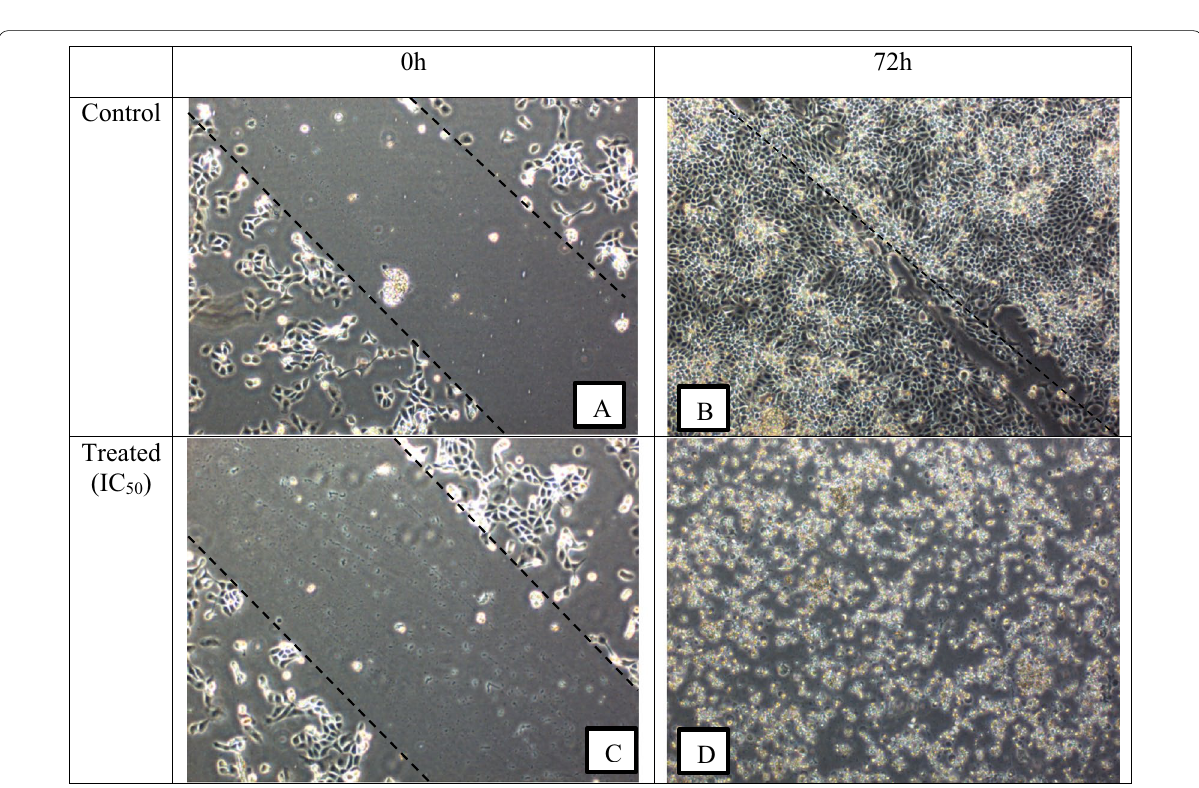
Fig. 6 Representative wound healing assay image over 72-h period detected by the inverted microscope. A , B Cellular migration of control cells MCF-7. C and D Cellular migration of cells treated with IC 50 dose of CNDCM fractions extracts. From these images, it is clear that cellular migration is slowed and not healed, while the presence of CNDCM inhibits proliferation. The control images show a completely ‘healed’ scratch after 72